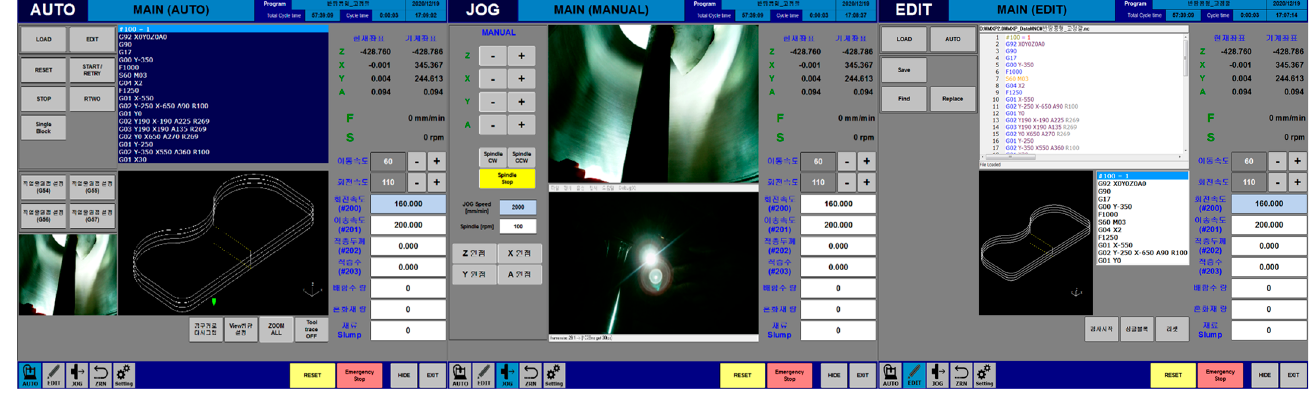
Figure 8. HMI of 3DCP